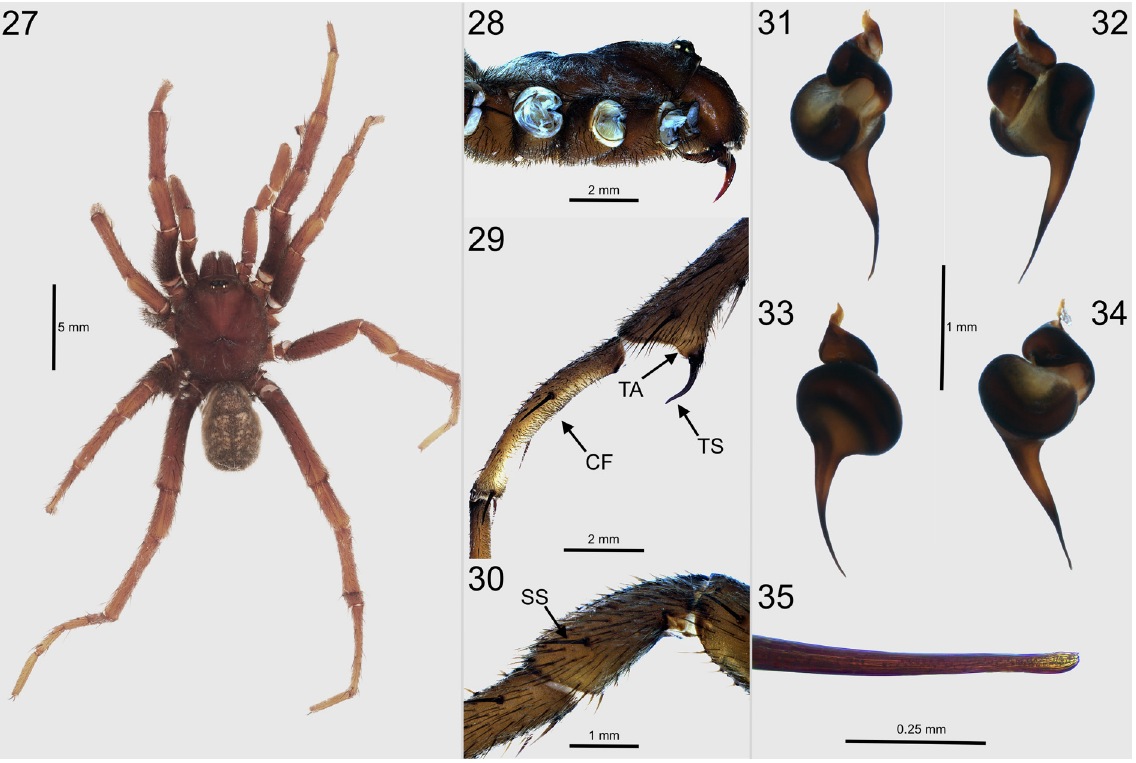
Figs 27–35. Nemesia arboricola Pocock, 1903, ♂ reference specimen (TD.4, NHMR). 27 . Dorsal habitus. 28 . Prosoma lateral, note slight elevation of the cephalic part, ocular process and gradual posterior slope of thoracic part. 29 . Metatarsus and tibia leg I, note tibial apophysis (TA), tibia spur (TS), clasper field (CF). 30 . Prolateral patella III with single spine (SS). 31–34 . Right palpal organ in four different positions rotated clock-wise by 90°. 31 . Ventral view, 32 . Prolateral view. 33 . Dorsal view. 34 . Retrolateral view. 35 . Embolus tip at high magnification, note slightly scooped